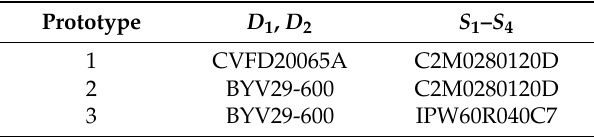
Table 3. Power Devices of the Prototype.